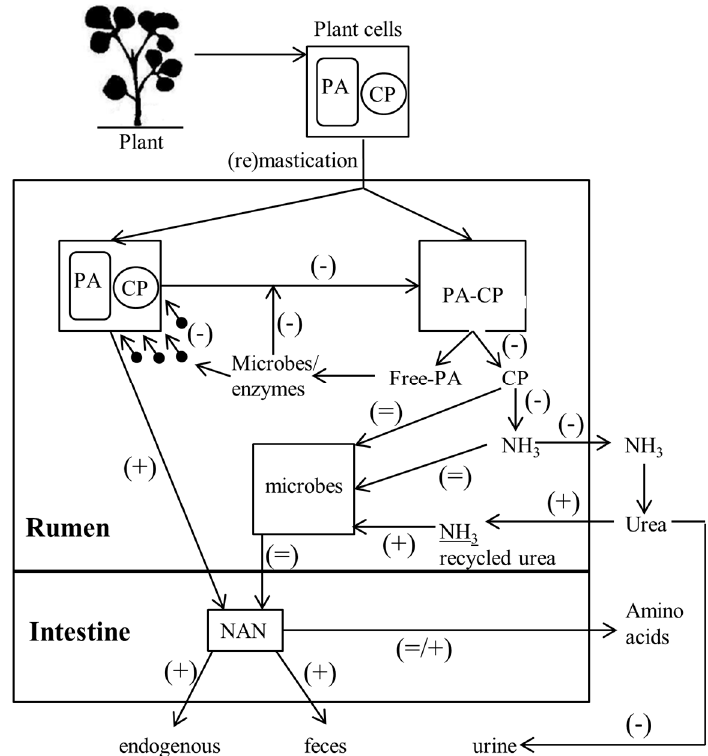
Figure 3. Schematic flow chart of crude protein (CP) digestion from proanthocyanidin (PA)-containing forage. Symbols between brackets represent the effect of PA-containing vs. PA-free forage on protein flow: + represents increased flow, − represents decreased flow and = represents similar flow. NAN: non-ammonia N. This figure was prepared with information from references [38,39,45– 47].